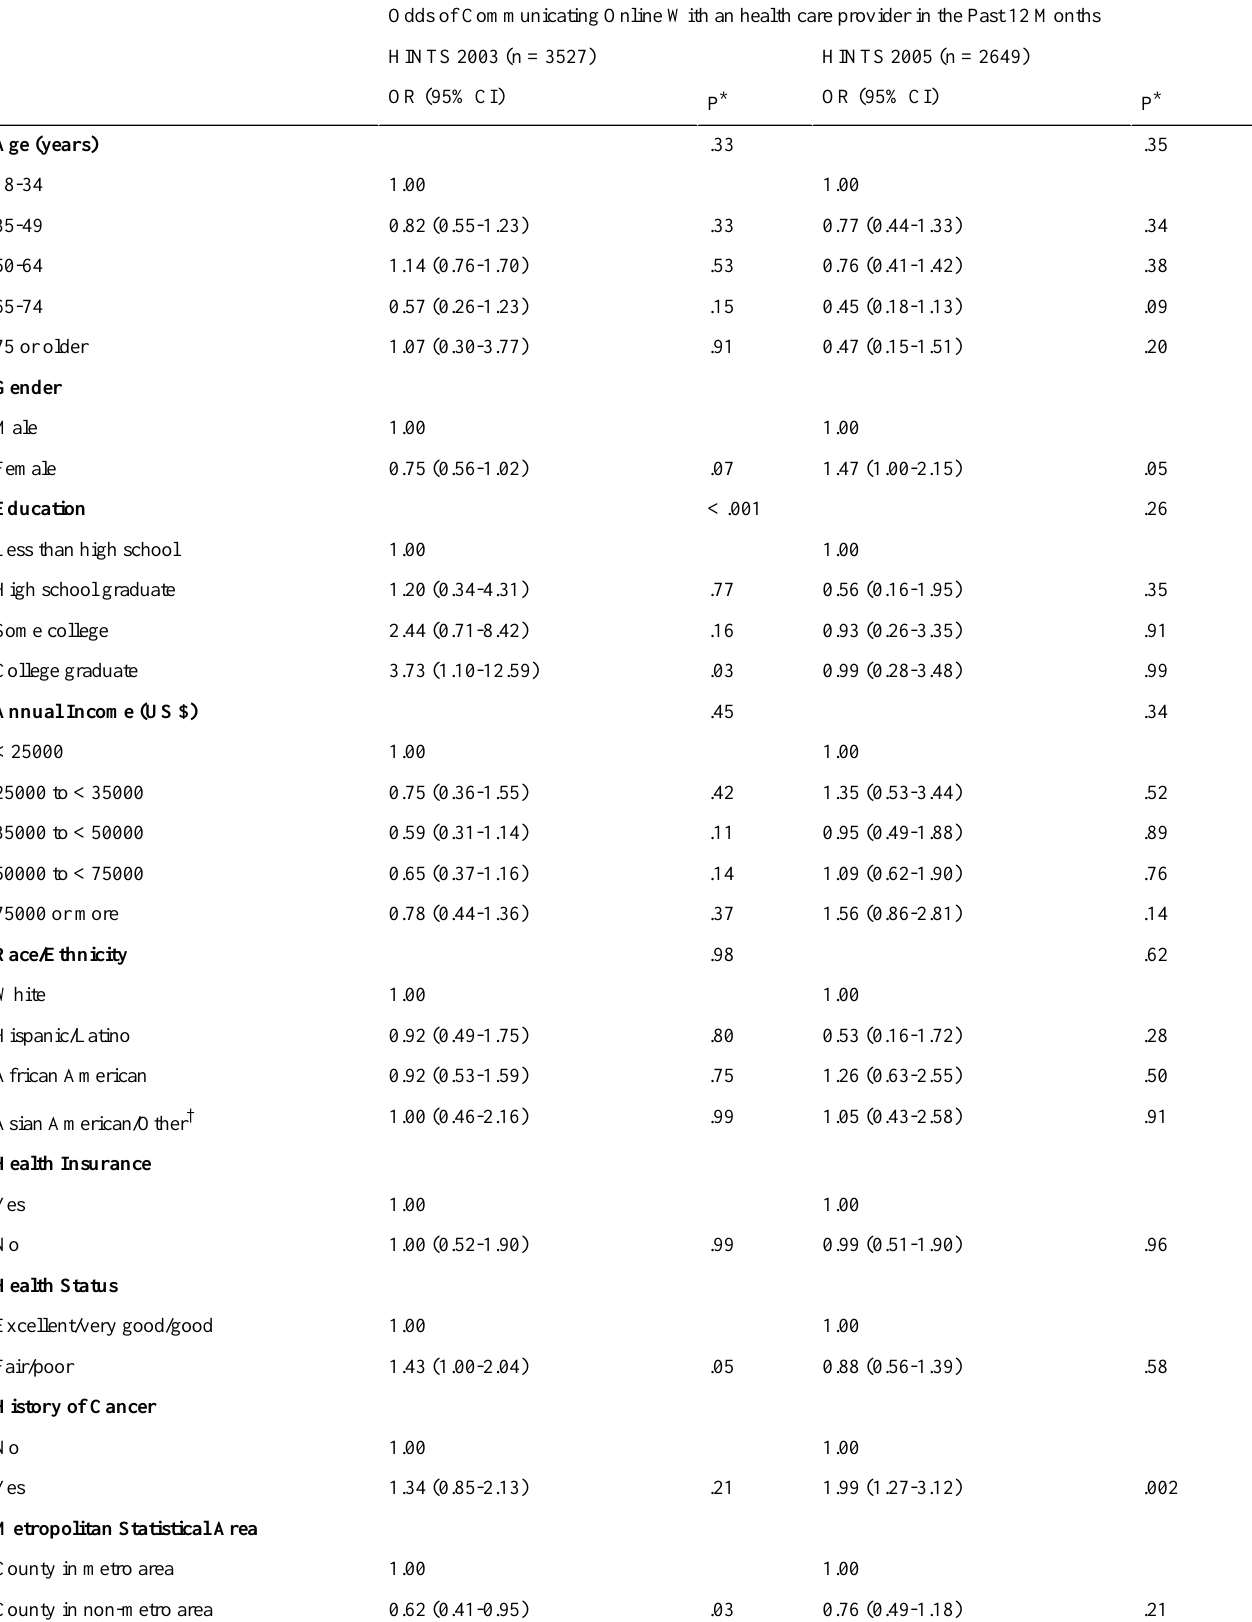
* P values reported for category headings for study variables with more than 2 categories refer to main effects. † Other includes Pacific Islander, Native Hawaiian, American Indian, Alaska Native, and multiple races